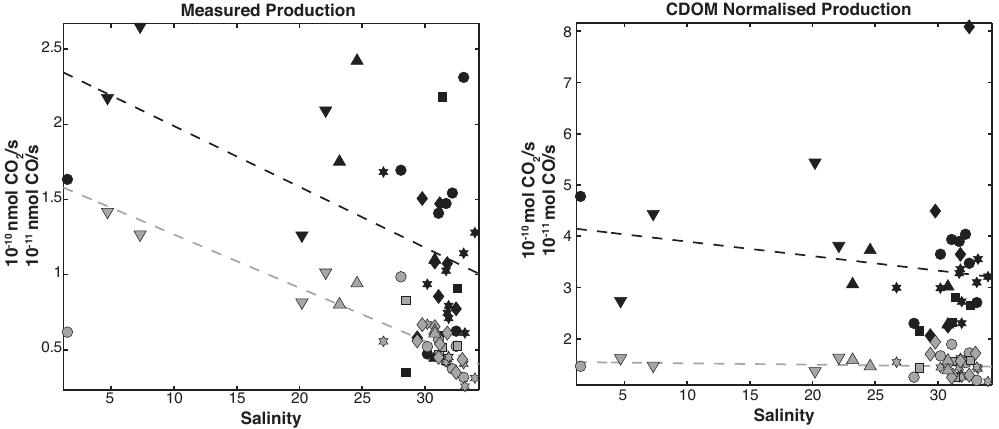
Fig. 4. Measured production and CDOM normalized production with respect to salinity. Black symbols represent CO 2 ( R 2 = 0 . 27 measured, 0.04 normalized) and grey symbols represent CO ( R 2 = 0 . 77 measured, − 0.08 normalized). Symbol key: circle – Altamaha high tide, pointing down triangle – Altamaha low tide, star – Sapelo high tide, square – Sapelo low tide, diamond – Doboy high tide, pointing up triangle – Doboy low tide.